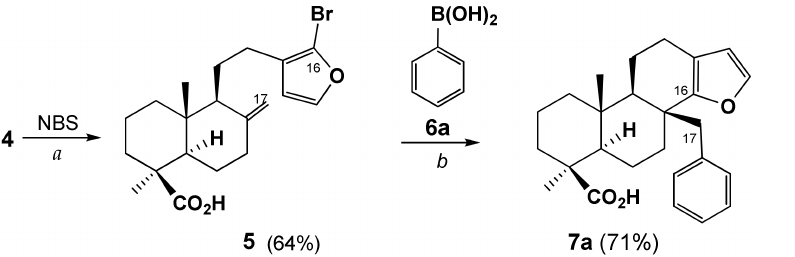
Scheme 1. Synthesis of 17-phenylisospongian-13(16),14-dien-18-oic acid 7a a . a Reaction